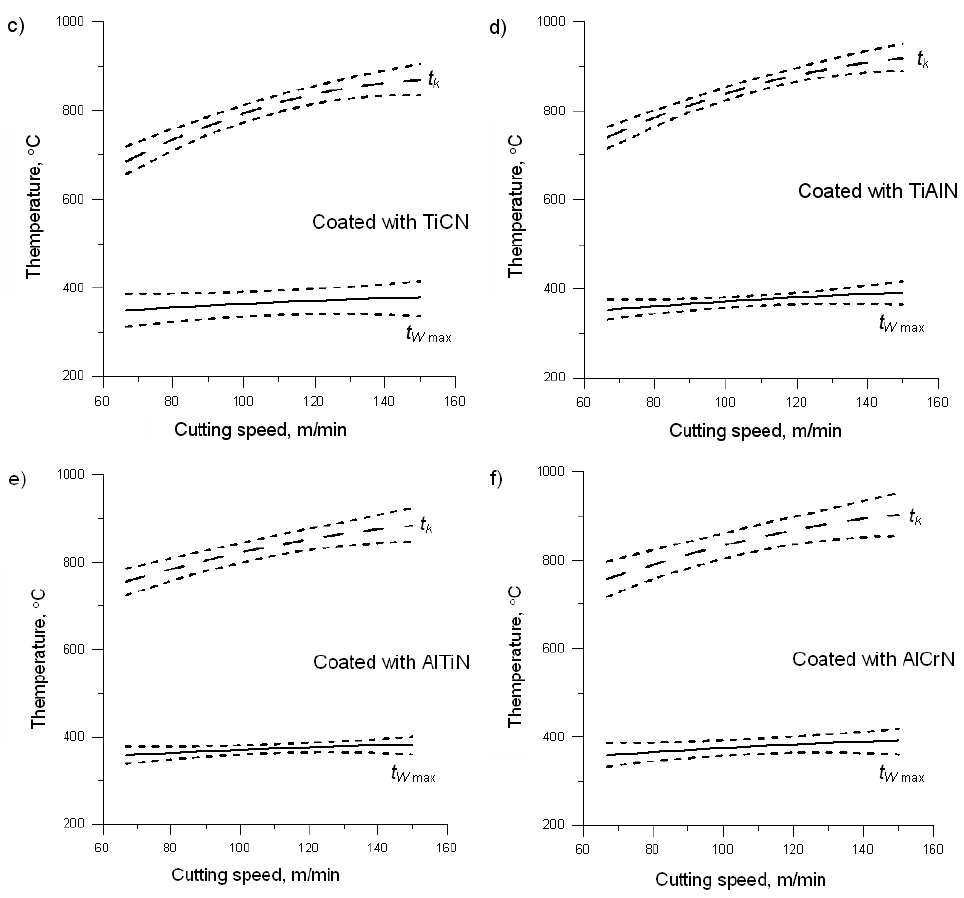
Figure 7. Contact and maximum temperatures of the chip surface for the H10F insert: ( a ) uncoated and coated with ( b ) TiN, ( c ) TiCN, ( d ) TiAlN, ( e ) AlTiN, and ( f ) AlCrN.